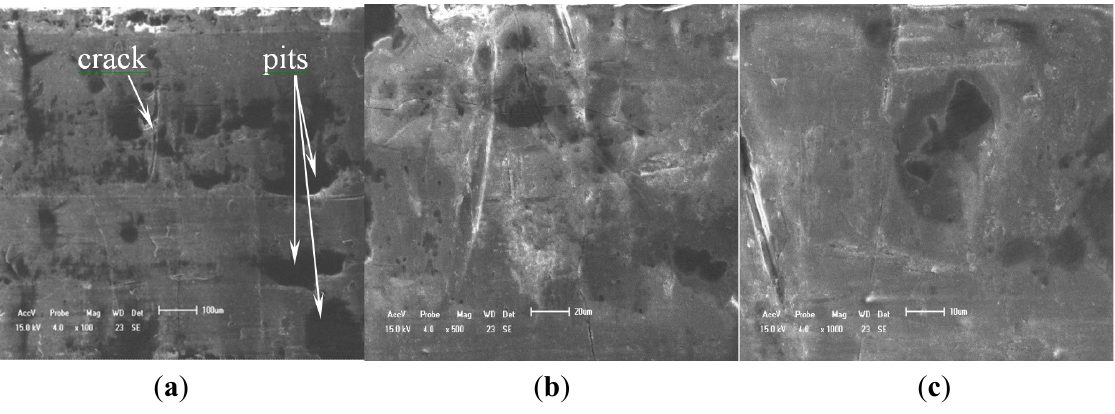
Figure 6. Typical surface morphologies of PEO coating with the pore sealing